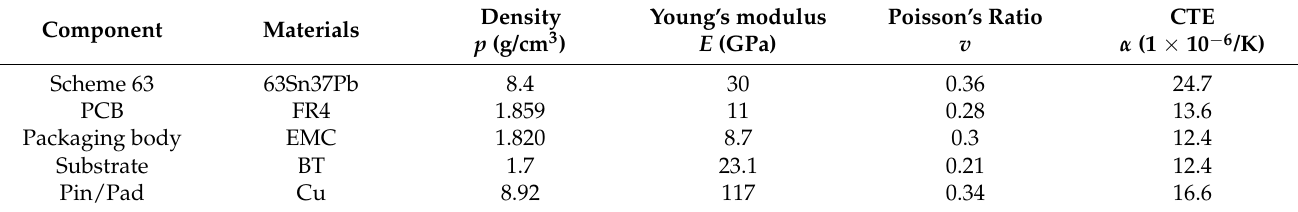
Table 4. The material parameters in FEA.